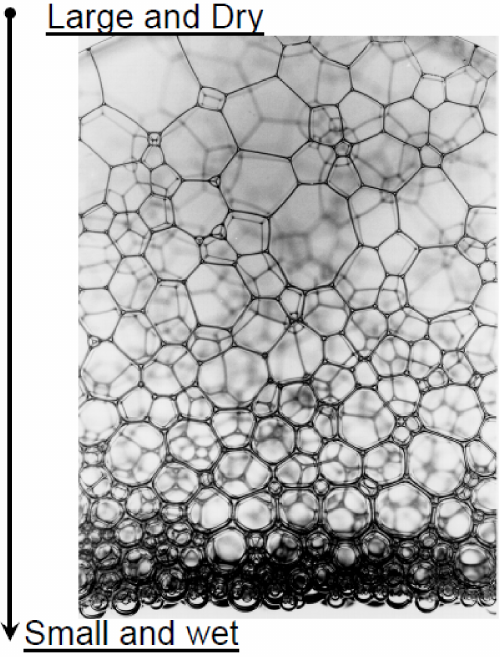
Figure 4. Difference of foam texture with quality (Davis et al.